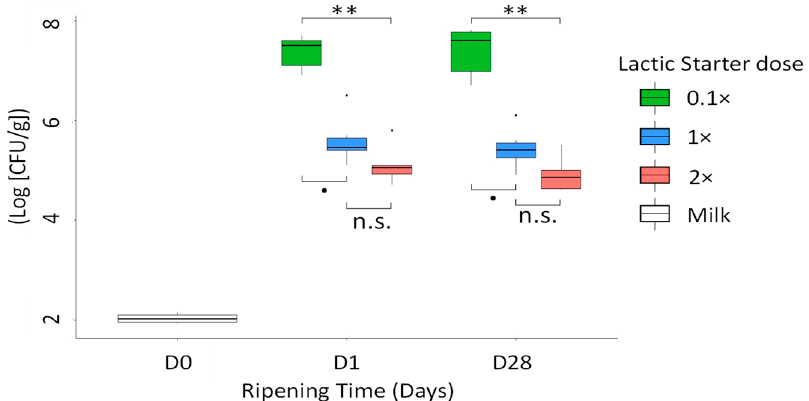
Figure 2. Level in Log [CFU/g] of STEC O26:H11 in milk (D0) and in cheeses at D1 and D28, ac- cording to the lactic starter dose ( n = 6). The differences according to the dose were estimated by a multiple comparison test, a Dunn’s test. ** p < 0.01; • tendency; n.s. non-significant. For milk samples multiple comparison test, a Dunn’s test. ** p < 0.01;  tendency; n.s. non-significant. For milk sam- ( n = 6), no statistical tests were ples ( n = 6), no statistical tests were performed.